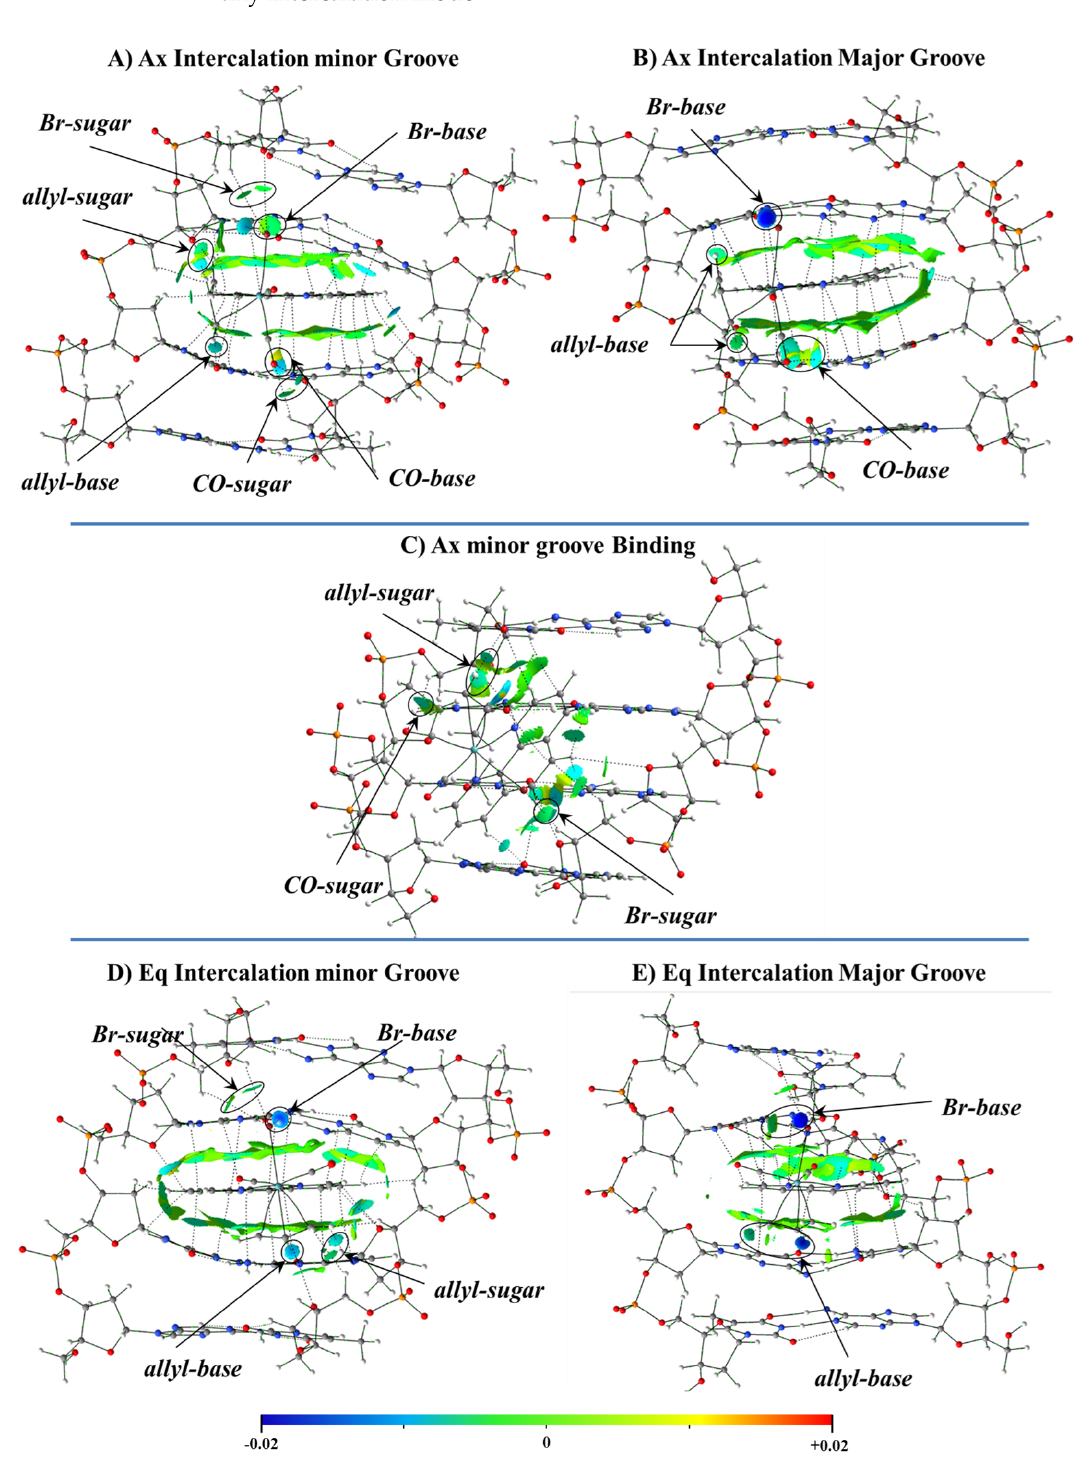
Figure 24. NCI plots for the different modes of interaction of the most stable studied systems including Eq and Ax isomers of the [Mo( η 3 -C 3 H 5 )Br(CO) 2 (phen)] complex with the dDNA at the M11L/6-31+G(d,p) level of theory for all the atoms, except Mo with the Hay-Wadt LANL2DZ effective core potential and the associated basis set, with an added set of polarization functions: ( A ) Intercalation via mg of the Ax isomer, ( B ) Intercalation via MG of the Ax isomer, ( C ) mg groove binding of the Ax isomer, ( D ) Intercalation via mg of the Eq isomer and ( E ) Intercalation via MG of the Eq isomer.